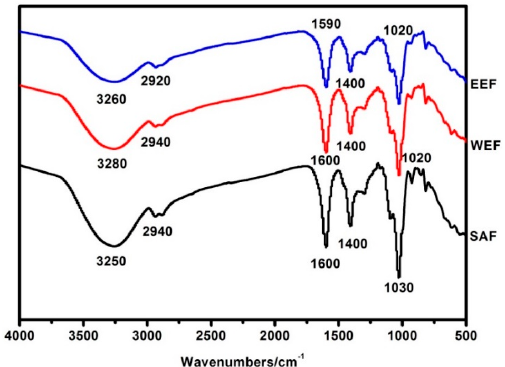
Figure 2. FT-IR spectra of SAF (Sodium alginate film), WEF (Sodium alginate incorporating water extract film) and EEF (Sodium alginate incorporating ethanolic extract